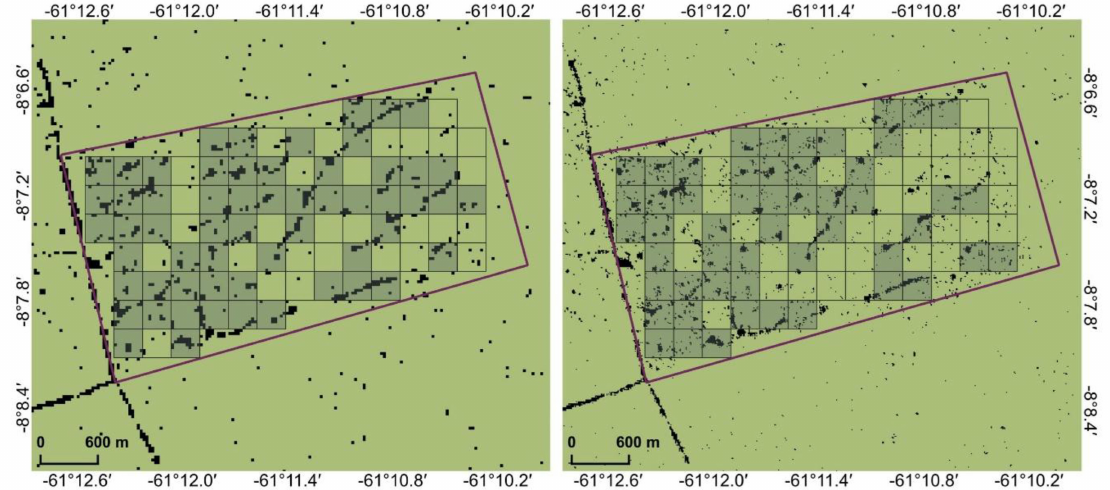
Figure 5. Grid-based approach (300 × 300 m) for SFM area Nº07. Grid cells classified as disturbed areas are shown as light grey for Landsat 8 (left) and Sentinel-2